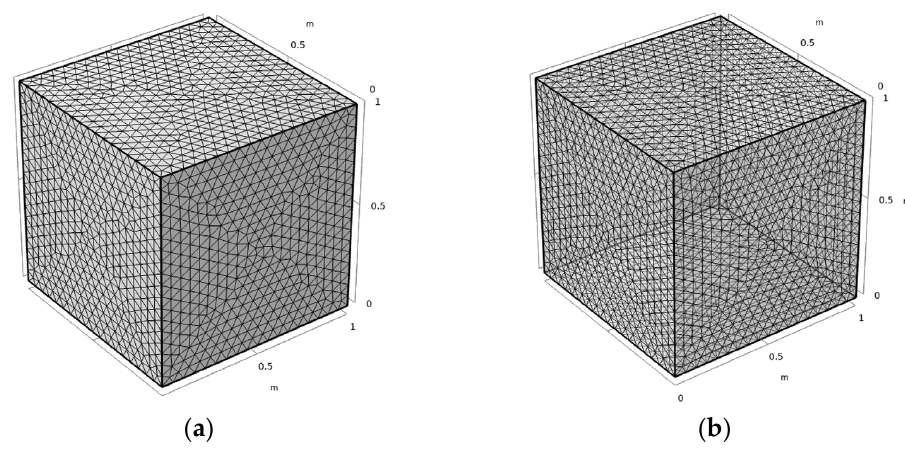
Figure 9. The finite element mesh model for the simulation. ( a ) Stereogram; ( b ) Perspective.